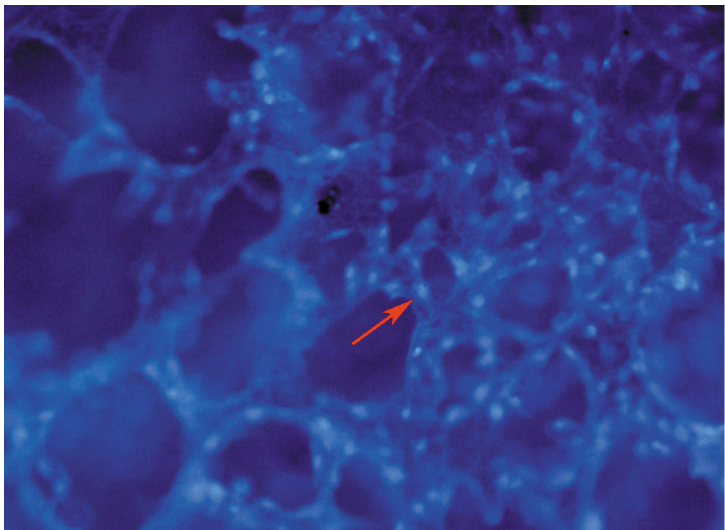
Fig 3. Fluorescent image of DAPI-labeled cells on pore surfaces of scaffolds. BMSCs adhered in the vicinity of the pores and its edges of a nHA-CS scaffold. Red arrows indicate labeled cells (figure magnification